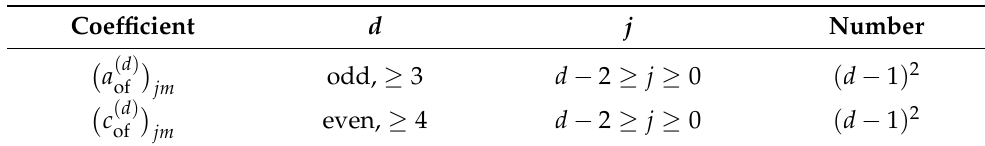
Table 1. Spherical coefficients for flavor-blind models. Adapted with permission from [91]. Copyright 2011 by The American Physical